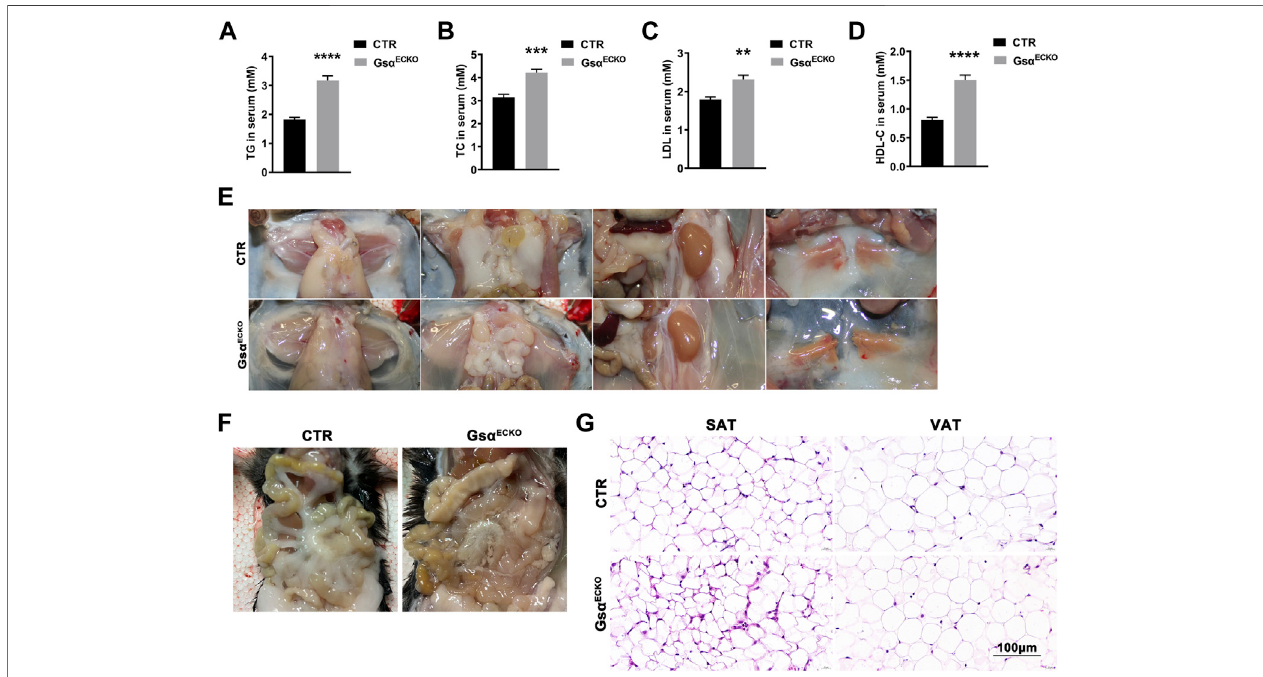
FIGURE 5 | Gs α ECKO mice displayed decreased blood lipid and adipose tissue. (A – D) Quanti fi cation of TG, TC, LDL and HDL-C in blood serum of CTR and Gs α ECKO mice. n = 5 to 6 per group. (E) Representative gross anatomy images of inguinal white adipose tissue (ingWAT), epididymal white adipose tissue (eWAT), perirenal white adipose tissue (prWAT) and interscapular brown adipose tissue (isBAT) from CTR and Gs α ECKO mice. (F) Representative gross anatomy images of mesentericwhiteadiposetissue(mWAT)tissuefromCTRandGs α ECKO mice. (G) Histologyofsubcutaneousadiposetissue(SAT)andvisceraladiposetissue(VAT) ofGs α ECKO andCTRmice.Scalebar,100 μ m.Dataareshownasmean±SEM.** p < 0.01;*** p < 0.001;**** p < 0.0001between2indicatedgroupsby2-tailedStudent